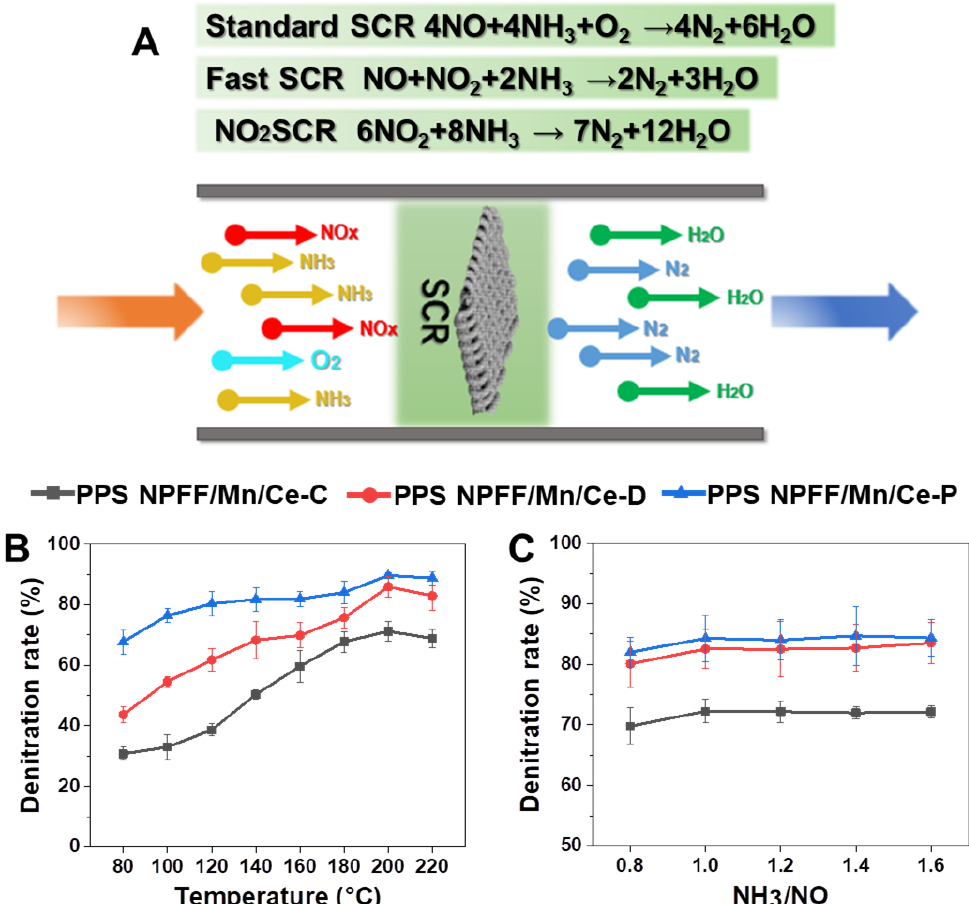
Figure 9. ( A ) Schematic model of the denitration mechanism by using our denitration; denitration rate for the three different Mn/Ce oxides decorated PPS NPFF as a function of ( B ) operating temperature and ( C ) NH 3 /NO flow ratio.